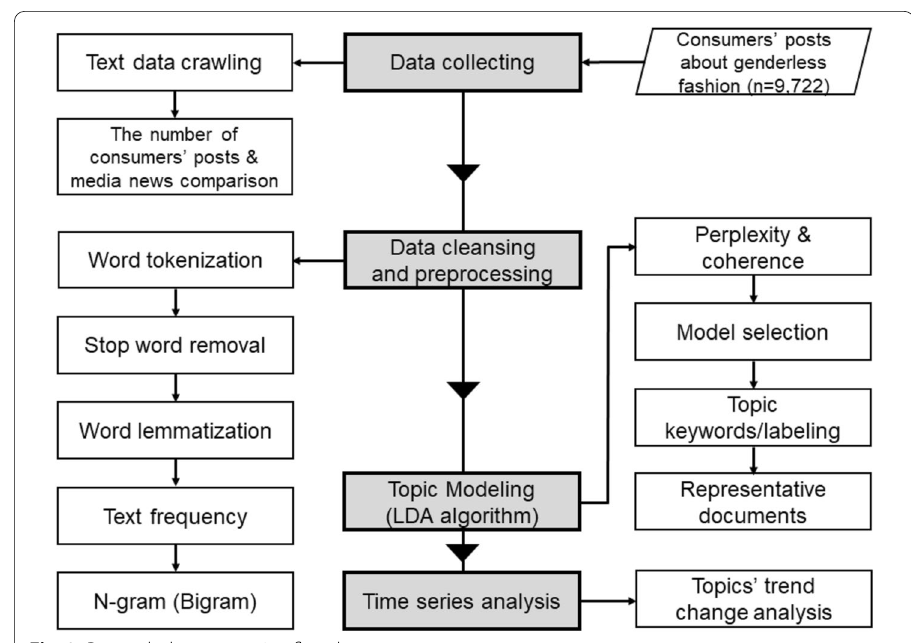
Fig. 2 Research data processing